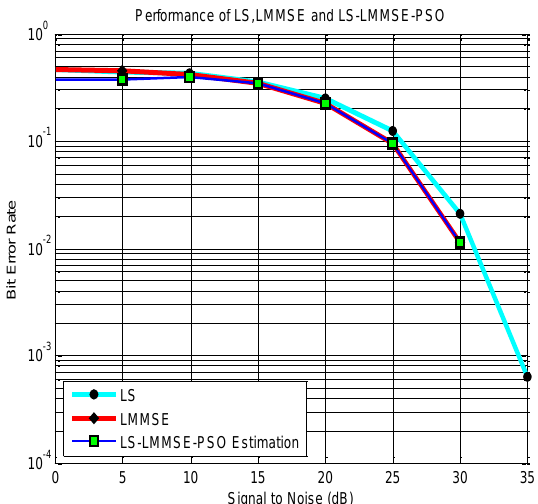
Figure 6: BER v/s SNR at Doppler frequency – 300 Hz